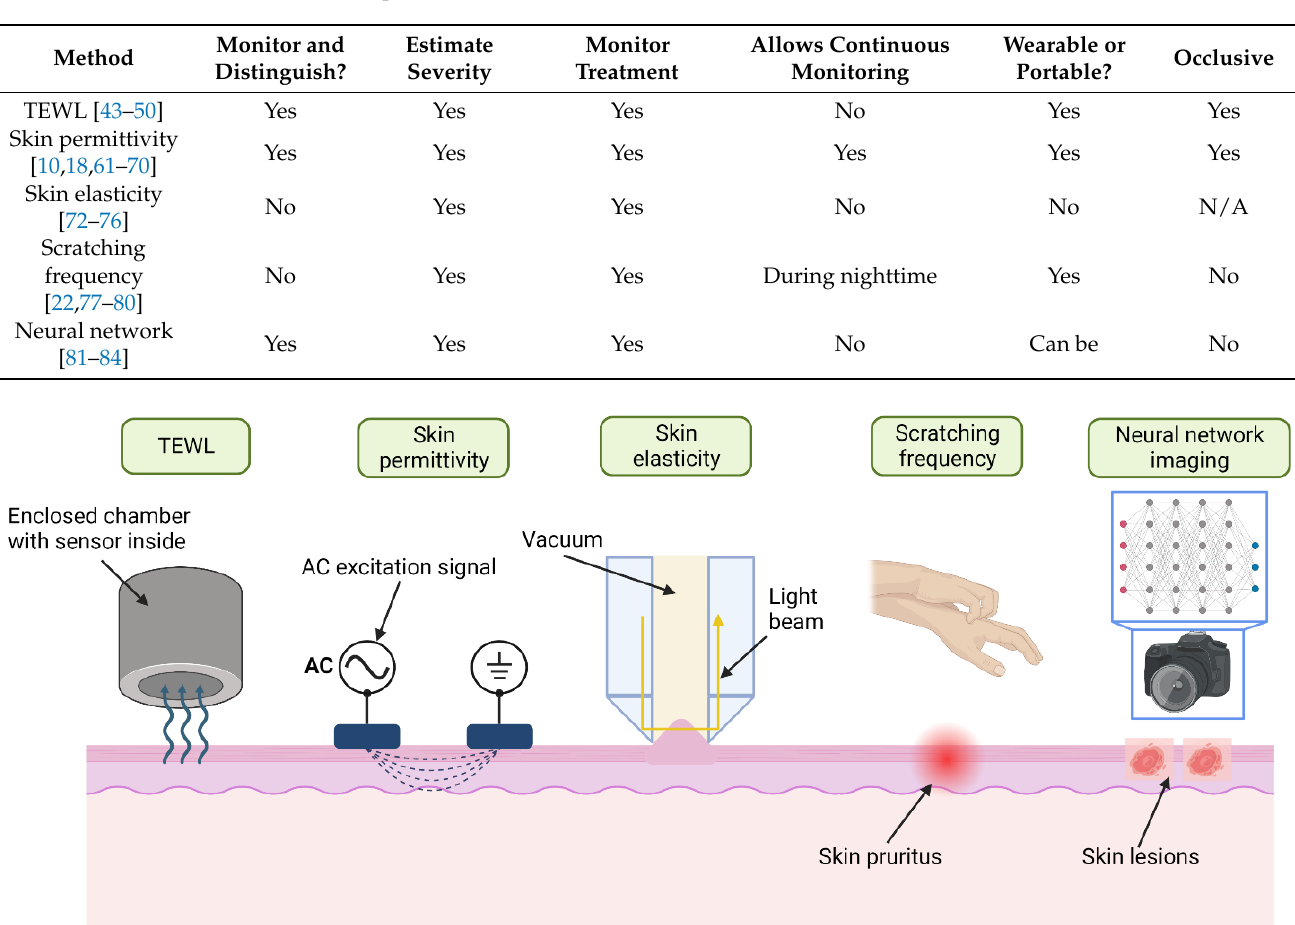
Table 2. Summary of telemedical solutions used in the literature for monitoring and distinguishing AD in patients.